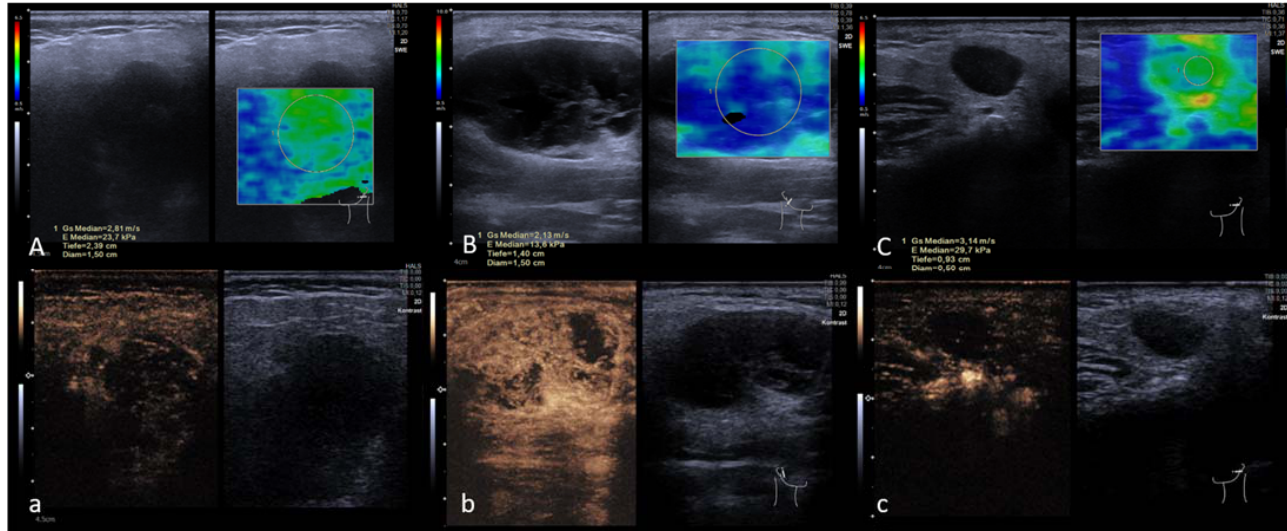
Figure 4. MpUS ‐ visualization of the three most common entities: SWE ( A ) and CEUS ( a ) of pleomorphic adenoma (PA), SWE ( B ) and CEUS ( b ) of Warthin’s Tumor (WT) and SWE ( C ) and CEUS ( c ) of squamous cell carcinoma (SCC). CEUS images were taken 50 s after SonoVue ® injection with WT and were more vascularized compared to PA and SCC at the point of measurement and PA and SCC showed higher SWE ‐ velocity compared to WT. SWE is measured by a circular ROI revealing tissue stiffness with a color ‐ coded elastography scale from blue (soft) to red (hard) and the minimum and maximum velocity given in m/s on the left side. The ROI’s stiffness is depicted on every SWE ‐ image’s left side in yellow. Please note that decimal signs on the images are depicted as commas instead of period signs due to the German ultrasound software preset. The symbol on the right bottom of the images represents the position of the US ‐ probe.